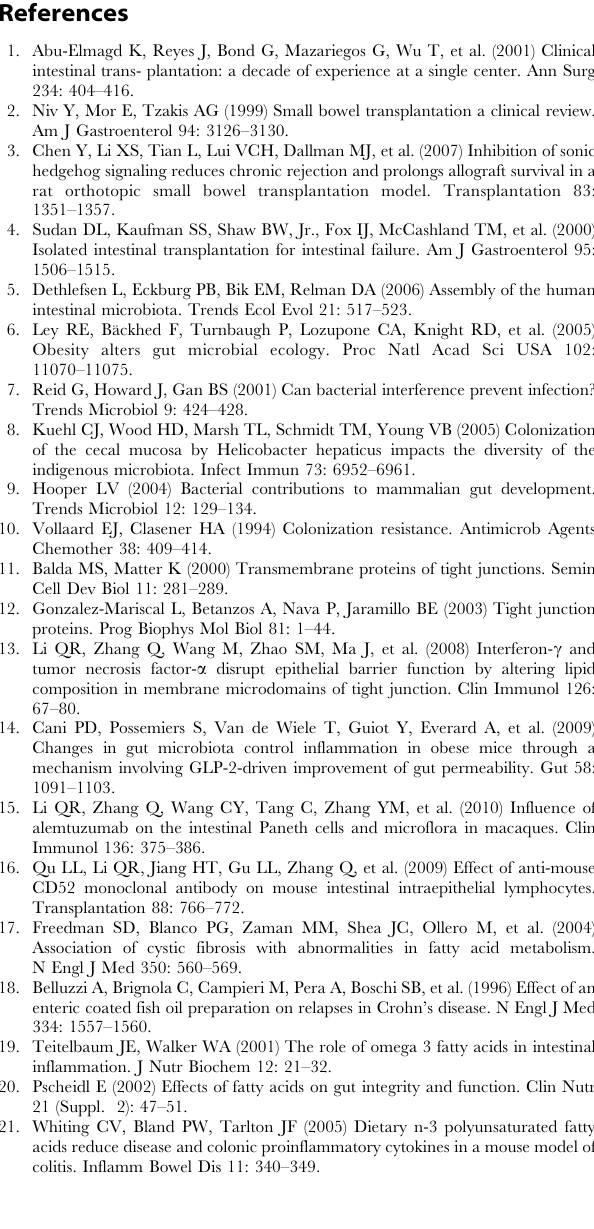
(A) Representative photomicrographs of the allograft intestine and recipients’ native ileal mucosa in rats after intestinal transplant (magnification 6 100). Widespread destruction of villi was observed in PBS and CO group. And fish oil prevented mucosal destruction. (B) Histopathologic findings of the rat colon (magnification 6 400). Sloughing of epithelium from the tips of the colon was present in CO group. And fish oil preserved mucosal